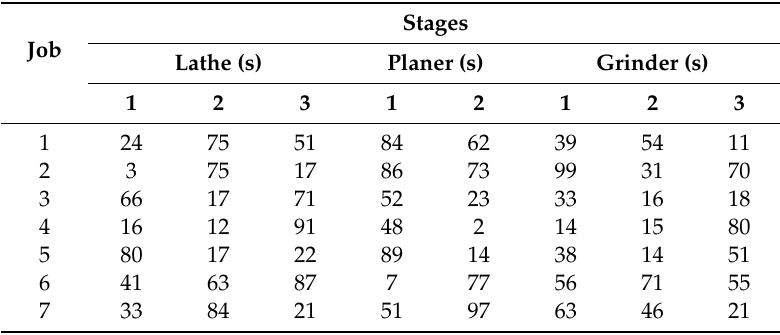
Table 4. The processing times in hybrid flow shop